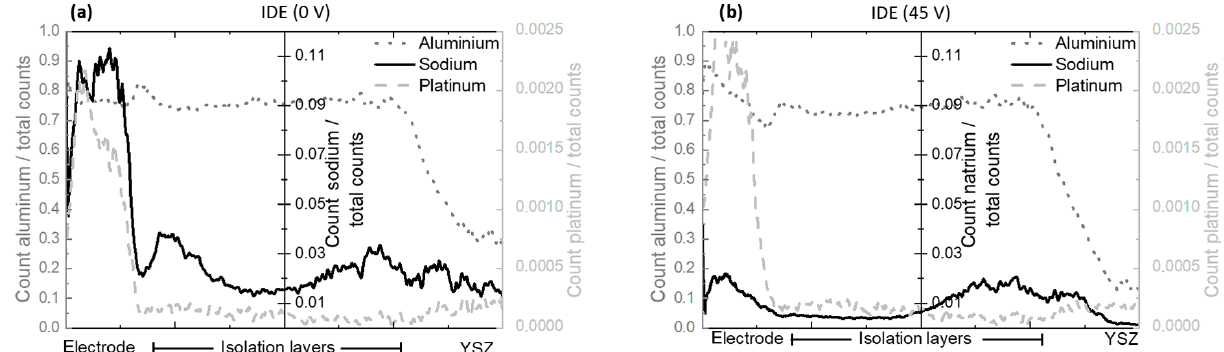
Figure 9. Depth profiles of aluminum, sodium and platinum measured by TOF–SIMS after a multiple sensor operation, where (a) is evaluated in the region of the grounded electrode and (b) is evaluated in the region of the 45V electrode.